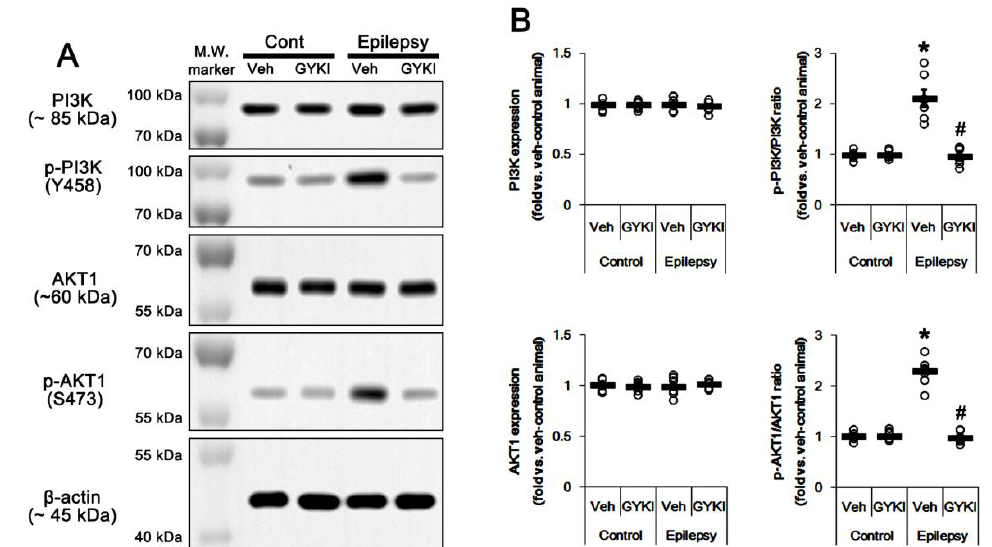
Figure 4. The e ff ect of GYKI 52,466 (GYKI) on PI3K and AKT1 expressions and their phosphorylations in control (cont) and epileptic rats. (A) Representative images for Western blot of PI3K, phospho (p)-PI3K, AKT1, and p-AKT1 level in the hippocampal tissues. (B) Quantifications of PI3K, phospho (p)-PI3K, AKT1, and p-AKT1 level in the hippocampal tissues. Open circles indicate each individual value. Horizontal bars indicate mean value. Error bars indicate SEM (*, # p < 0.05 vs. vehicle (Veh)-treated control animal and vehicle-treated animals, respectively; one-way ANOVA with post hoc Bonferroni’s multiple comparison; n = 7, respectively).